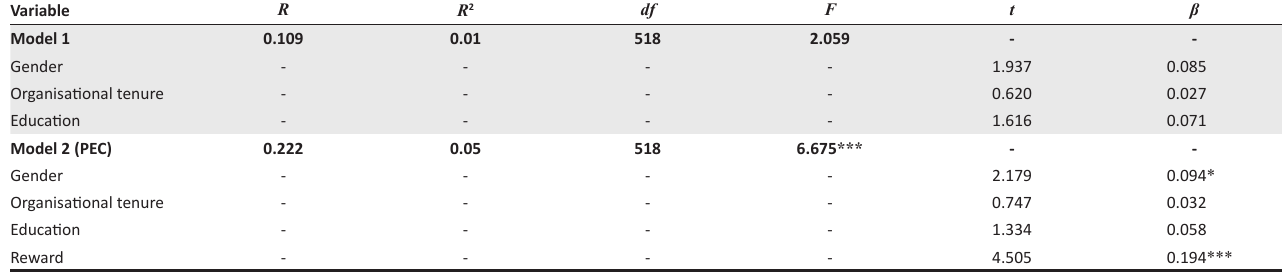
TABLE 5: Regression analysis of the influence of reward on performance evaluation criteria. Variable